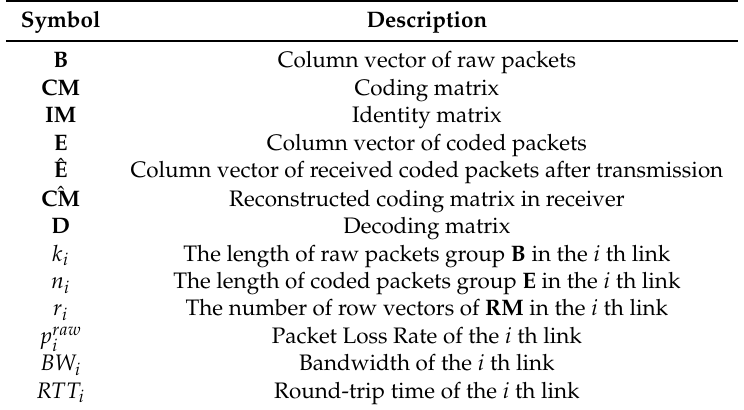
Table 1. Abbreviation